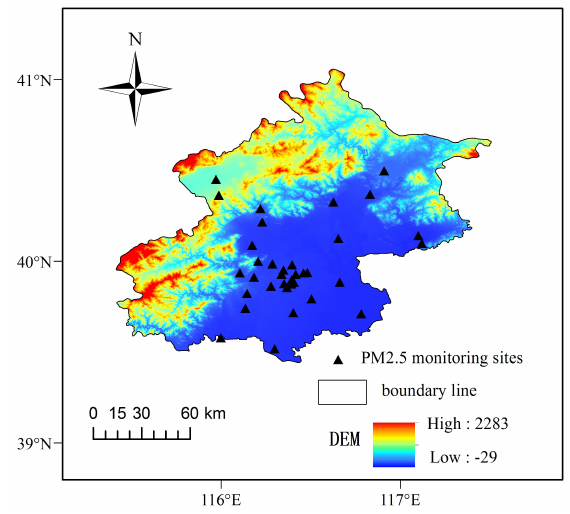
Figure1.Distribution map of Beijing PM2.5 monitoring